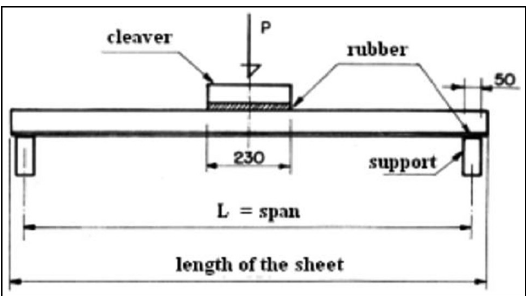
Figure 8. Boundary conditions: restrain of the displacements in the supports and in the central section of the sheet.